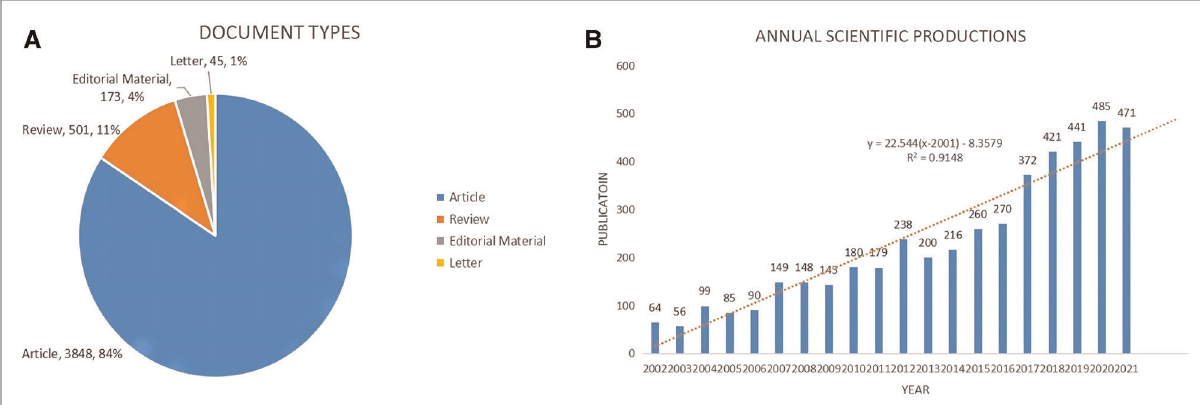
FIGURE 2 General information about arthroscopic therapy of rotator cuff diseases related publications from 2002 to 2021. ( A ) The document types of Arthroscopic Therapy of Rotator Cuff Diseases Related Publications. ( B ) The annual scienti fi c productions of Arthroscopic Therapy of Rotator Cuff Diseases Related